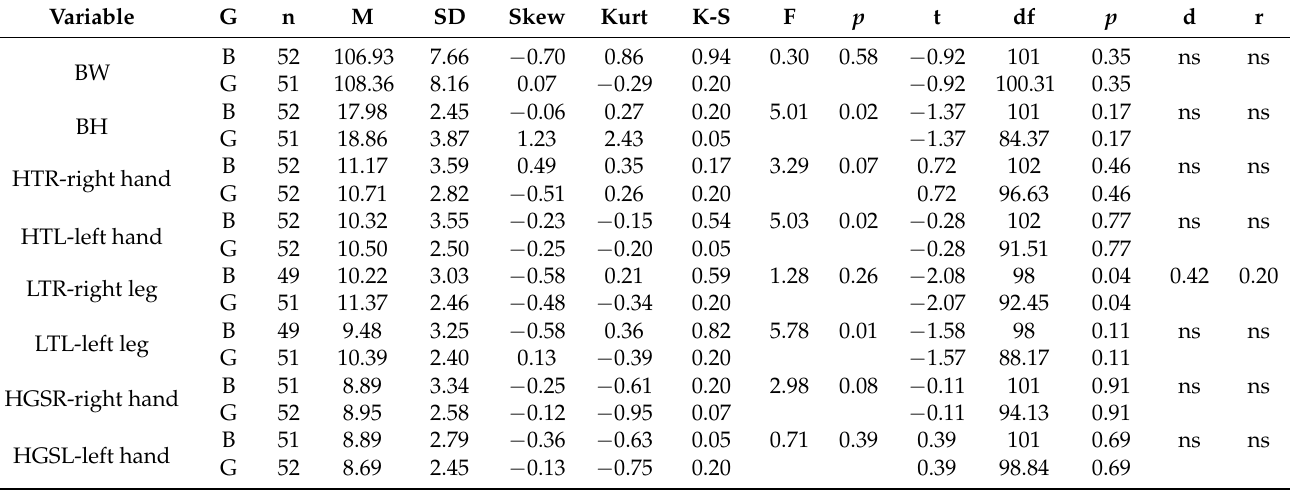
Table 1. t -test gender differences in anthropometric characteristics and motor performance of 3- to 6-year-old children.